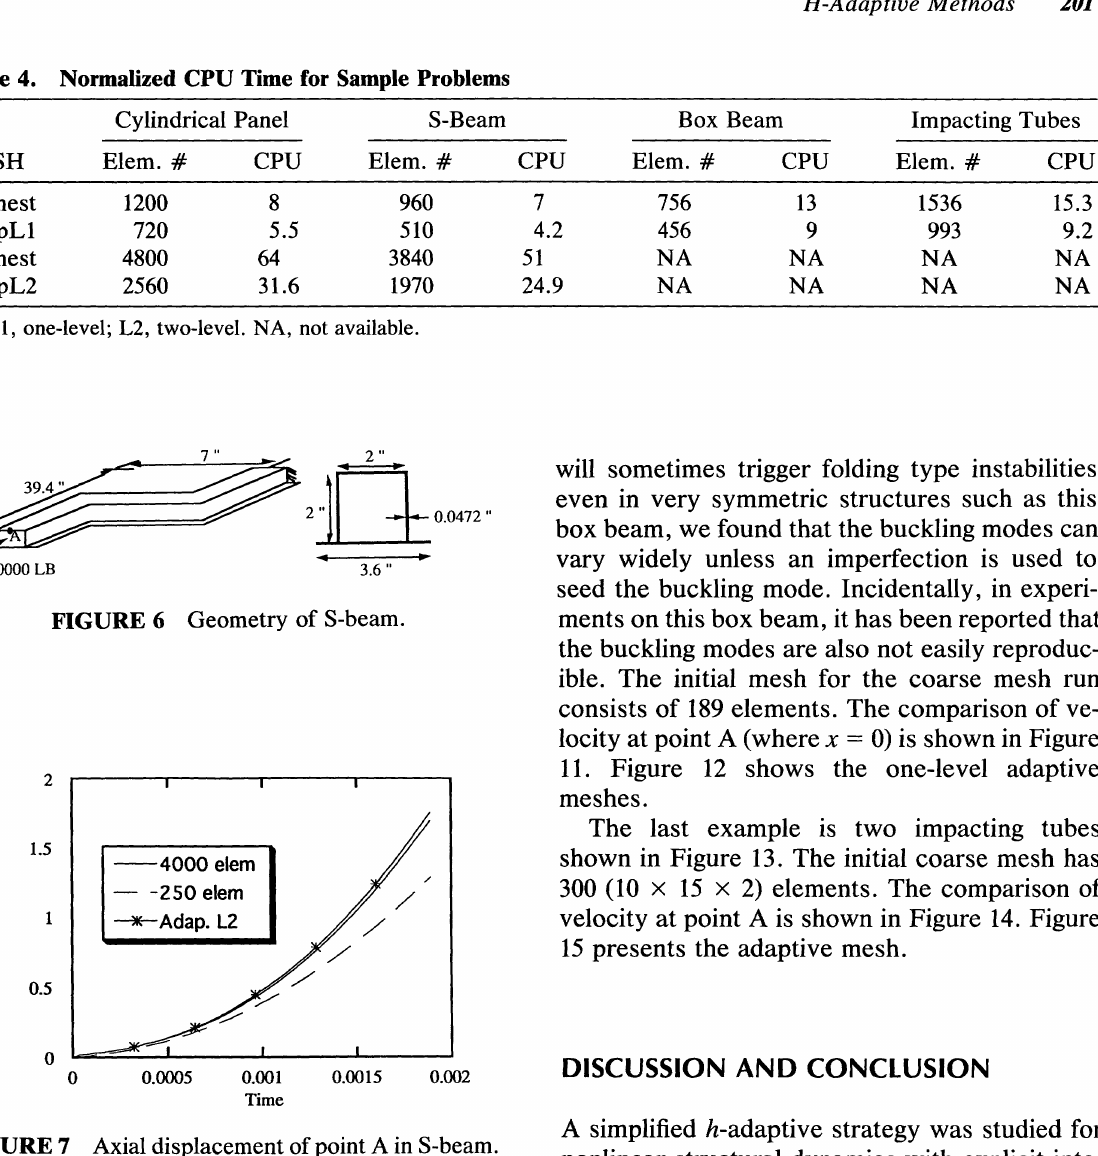
Table 4. Normalized CPU Time for Sample Problems